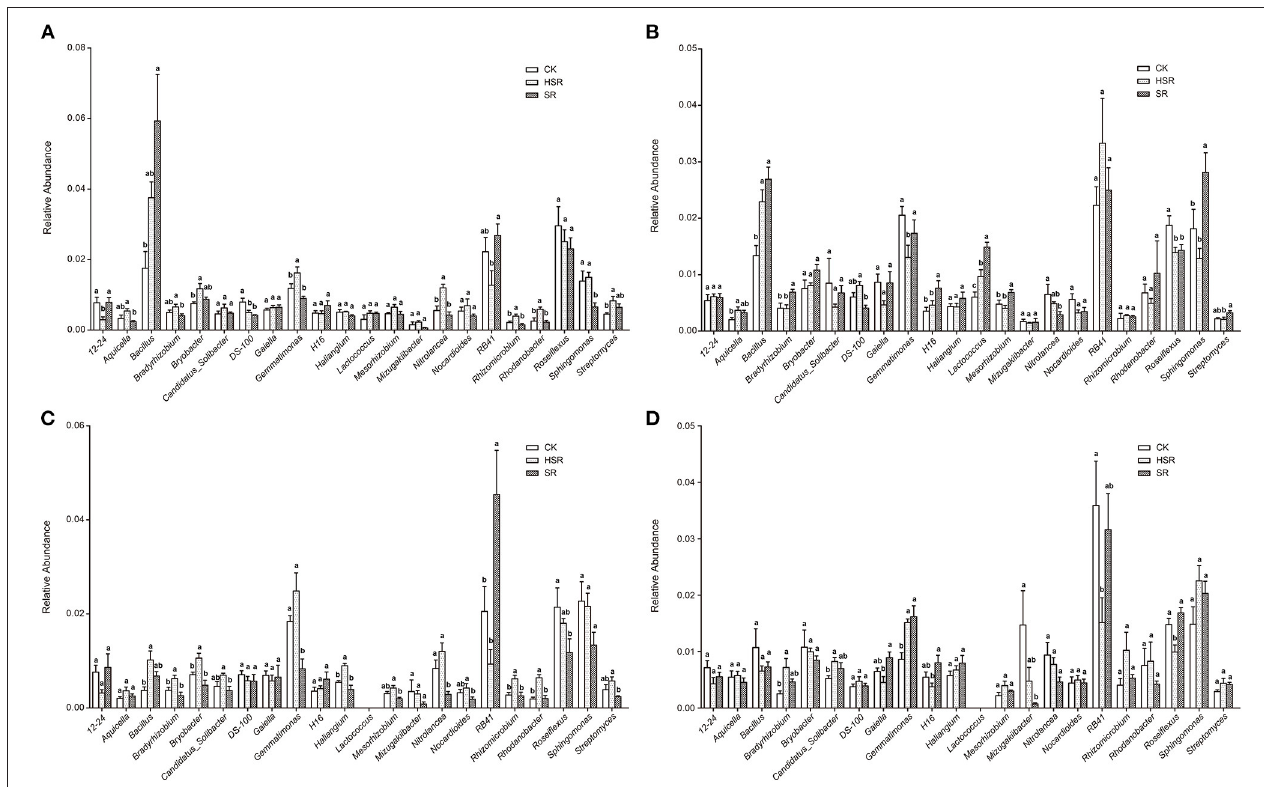
FIGURE 4 | Effect of different amounts of corn straw returned to the field on the genus and difference of dominant bacteria. (A) The jointing stage of the wheat season. (B) The harvesting stage of the wheat season. (C) The tasseling stage of the corn season. (D) The maturity stage of the corn season. Note: different letters in each column indicate significant differences at P < 0.05 (Duncan’s multiple range